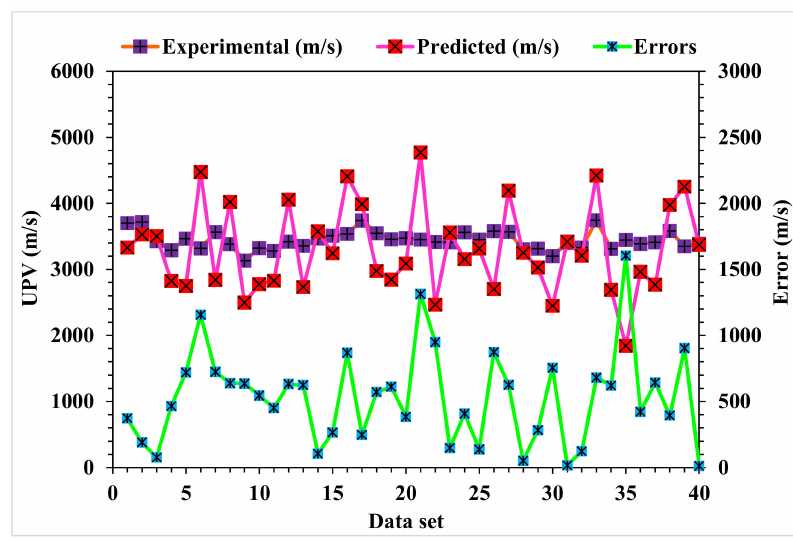
Figure 11. AdaBoost model experimental and predicted values with the